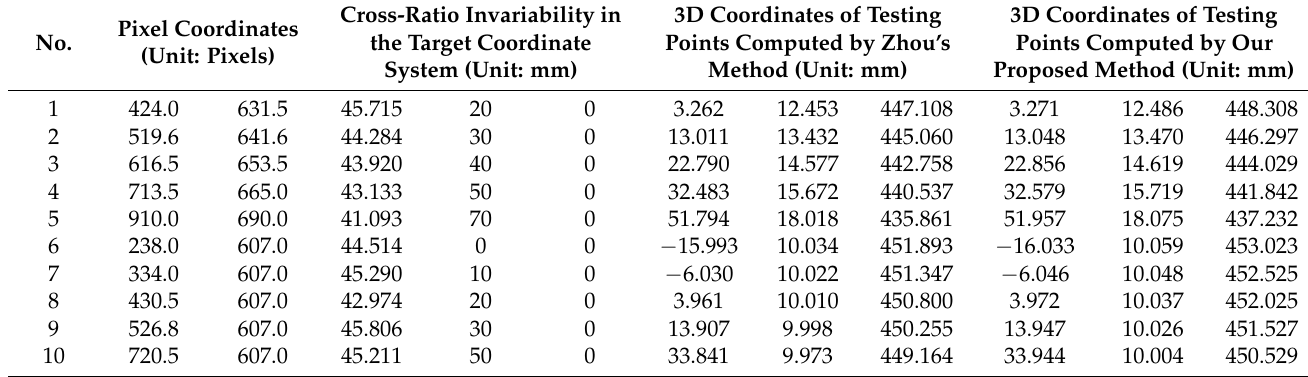
Figure 11. Schematic diagram of the evaluation strategy based on the cross-ratio invariability principle. Table 1. Three-dimensional coordinates of the ideal points and testing points computed by Zhou’s method and the method proposed in this study.